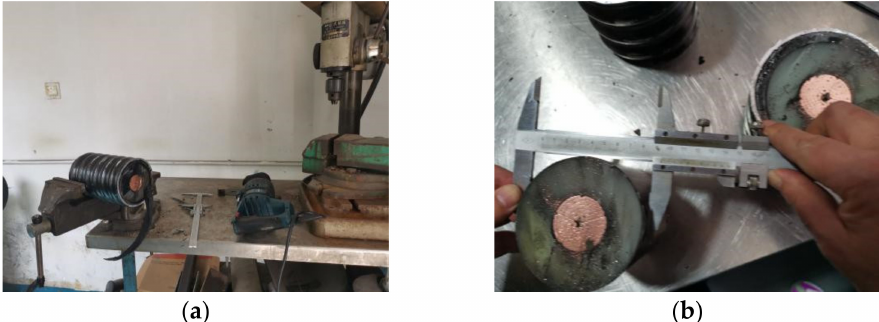
Figure 6. Experiment 2 processing diagram. ( a ) Part A and ( b ) Part B measuring stripped